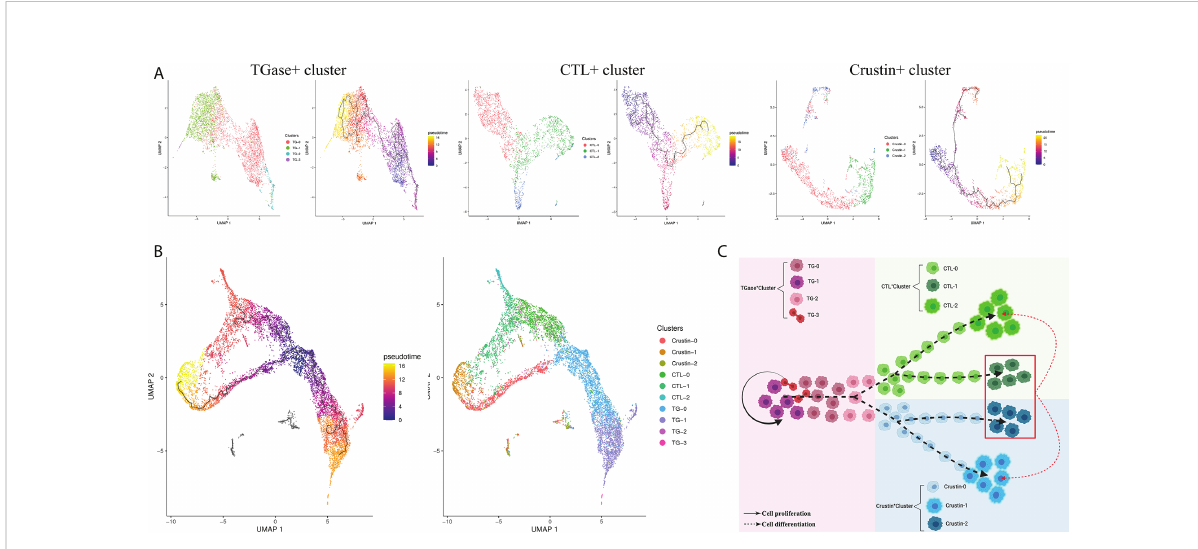
FIGURE 5 Diversity of hemocyte populations and their potential lineage. (A) Single-cell trajectory for the sub-clusters of TGase + cluster, CTL + cluster and Crustin + cluster. (B) Visualization of all sub-clusters onto the pseudotime map. (C) Schematic exhibiting potential lineage fl ow from the oligopotent state of TGase + cluster to mature cell types (CTL + cluster and Crustin + cluster) with their